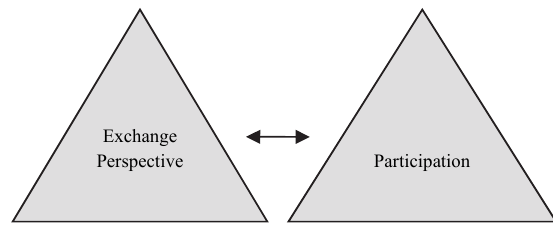
Fig. 3. Two activity systems in Dynamic